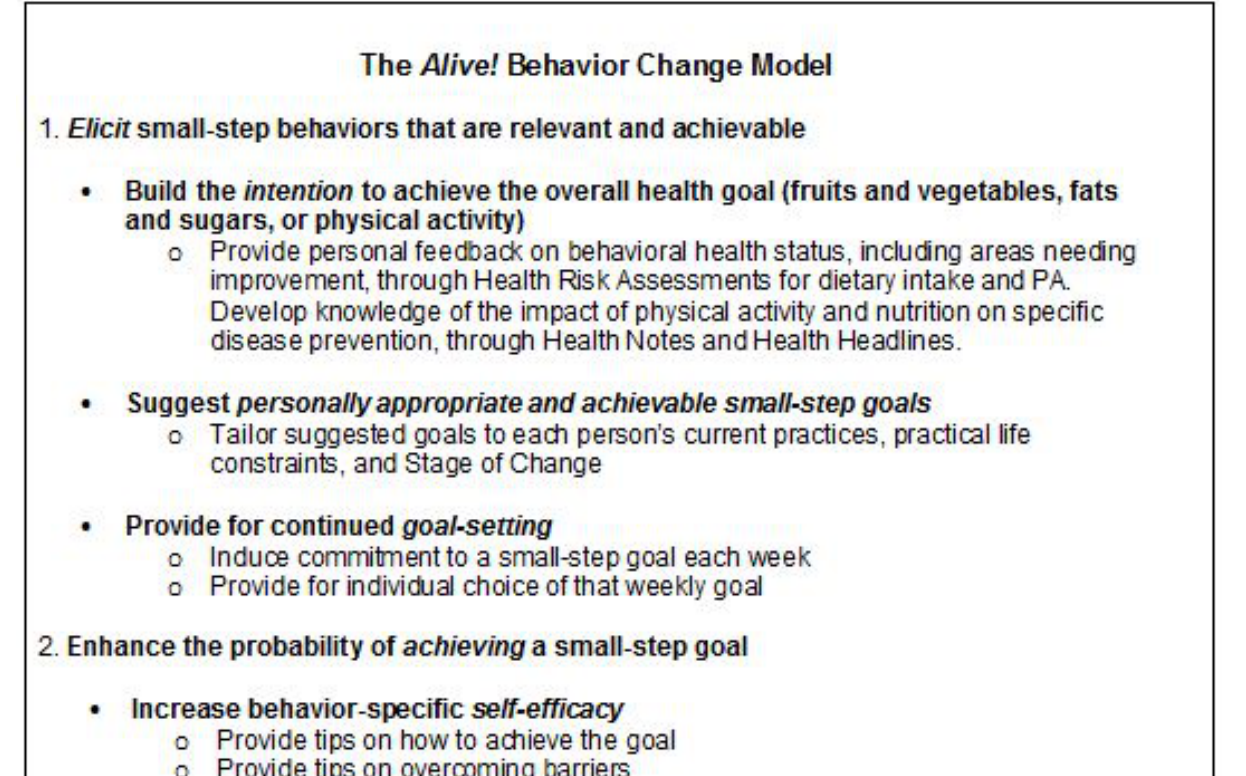
Figure 2. The Alive! behavior change